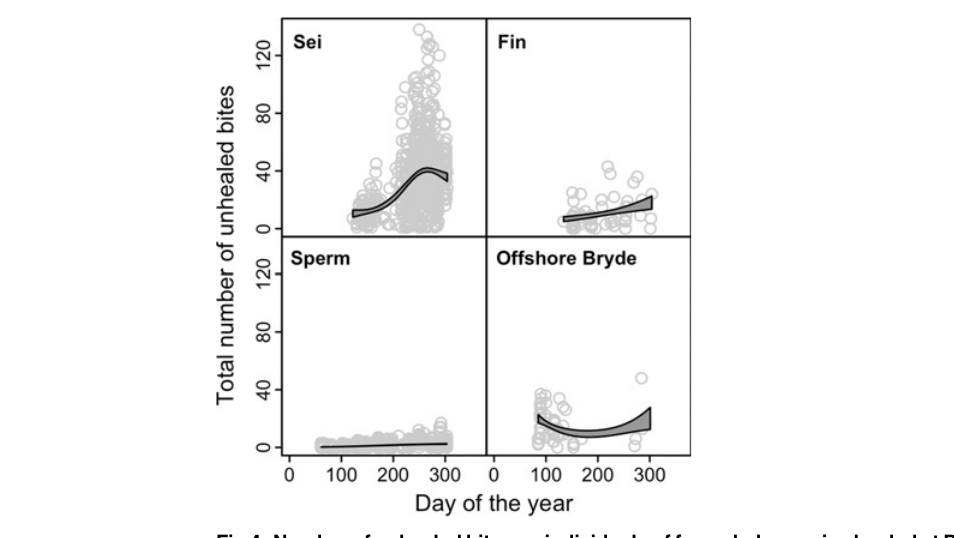
Fig 4. Number of unhealed bites on individuals of four whale species landed at Donkergat, 1963, plotted against date of